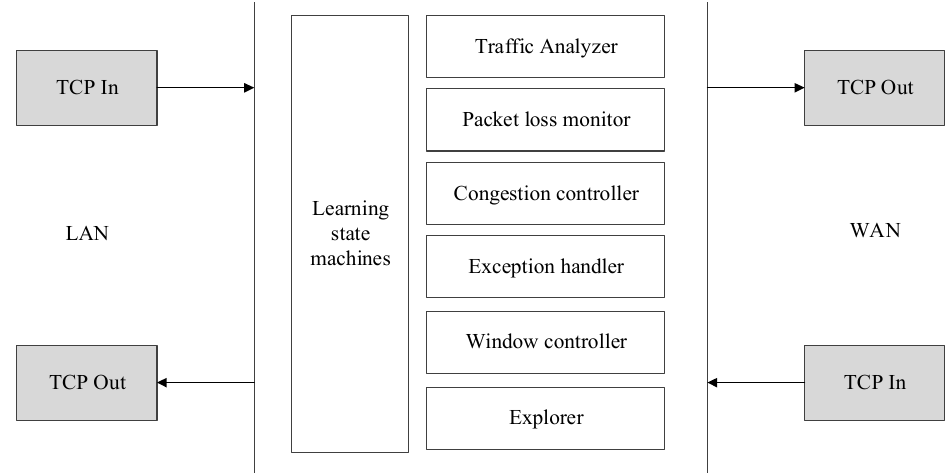
Figure 2. Schematic diagram of the BoostTCP modules.